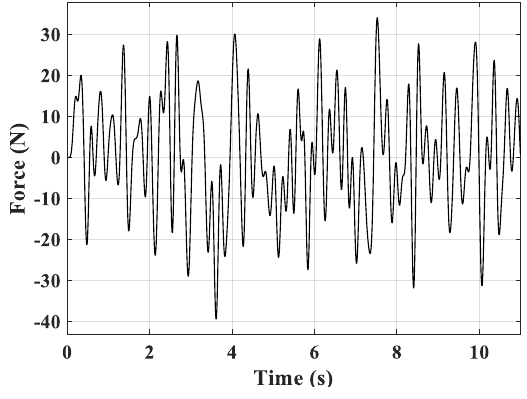
Figure 9. The random excitation.